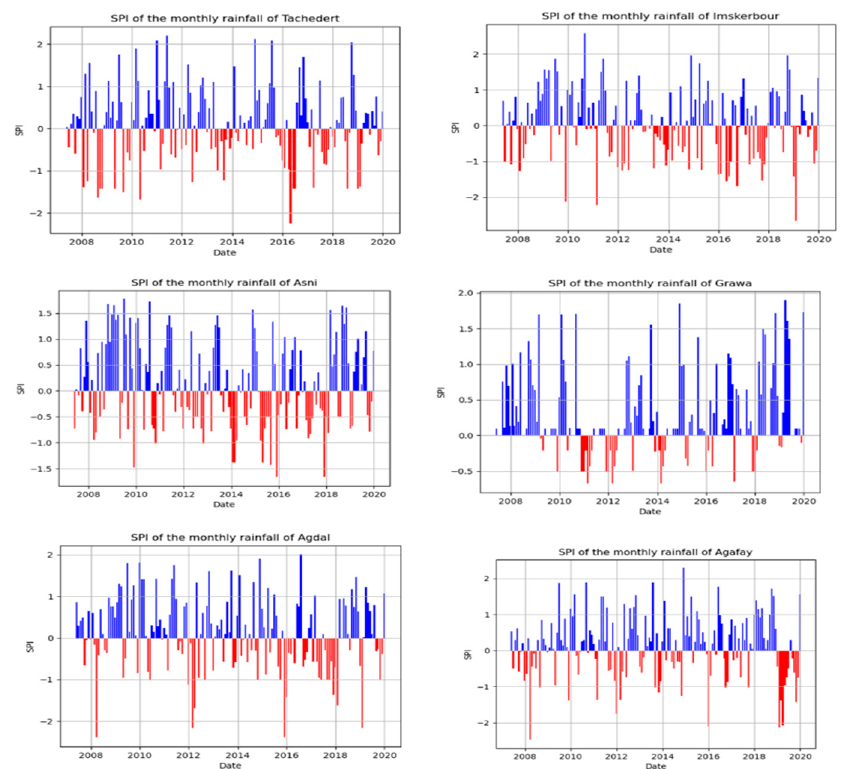
Figure 10. SPI of the monthly precipitation for the six weather stations in the Tensift